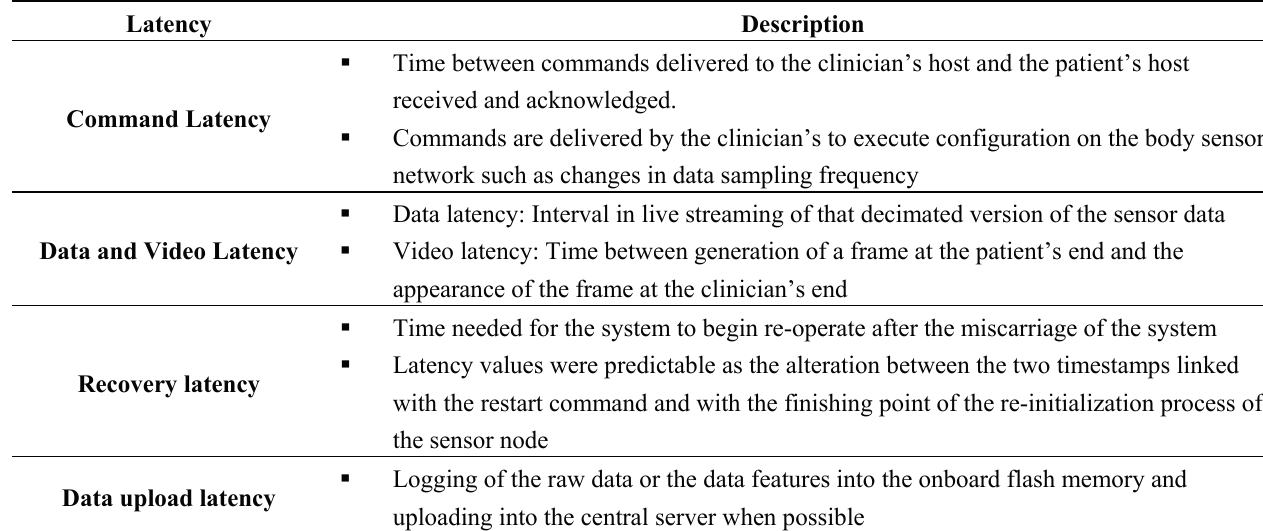
Figure 8. A general idea of the design of the home monitoring system (adapted from [53]). Table 5. Different types of latency and their description